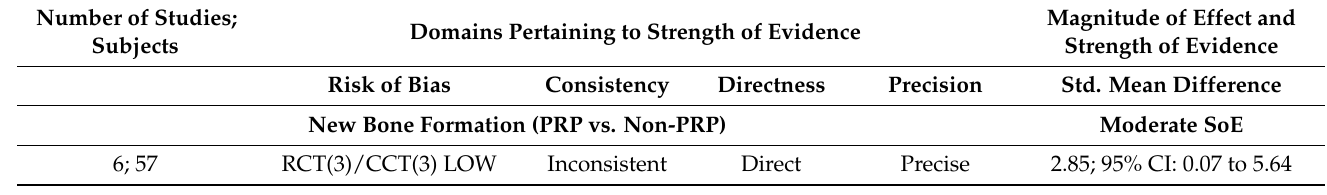
Table 3. PRP vs. Non-PRP strength of evidence. Summary of